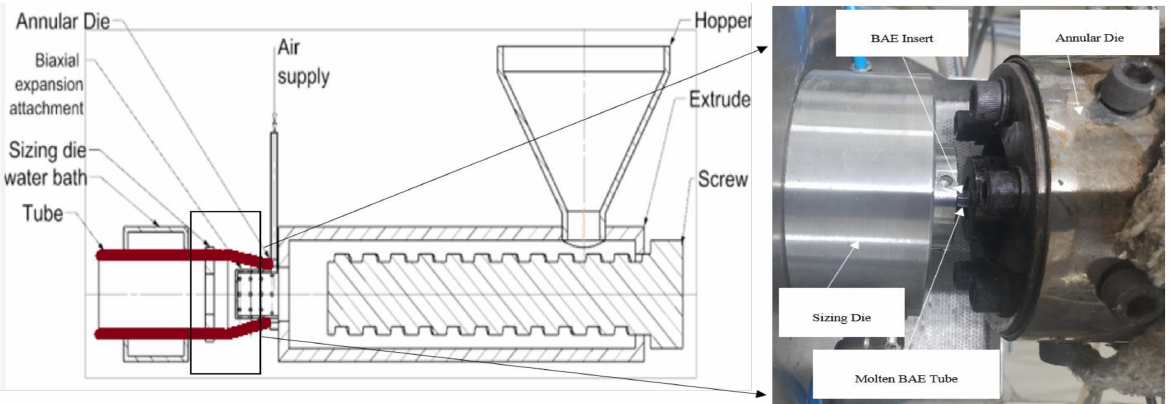
Figure 1. Biaxial expansion setup for tubular scaffold